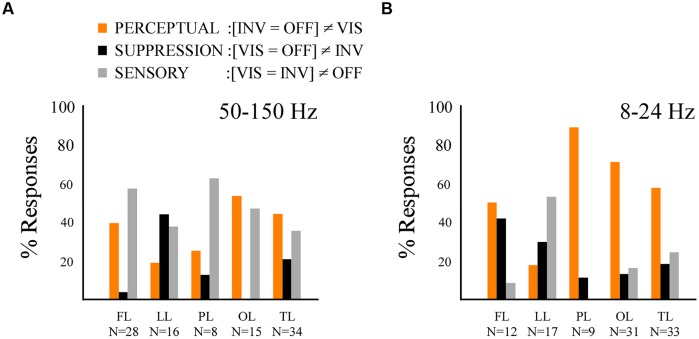
Results from the multiple comparison test revealing the perceptual, suppression and sensory effects. (A) Histogram displaying the percentage of response per effect type within the broad gamma band (50–150 Hz) across the five lobes, same conventions as in Figure 4A. (B) Histogram displaying the percentage of effect type response within the low-frequency band (8–24 Hz) across the five lobes, same conventions as in Figure 4A.